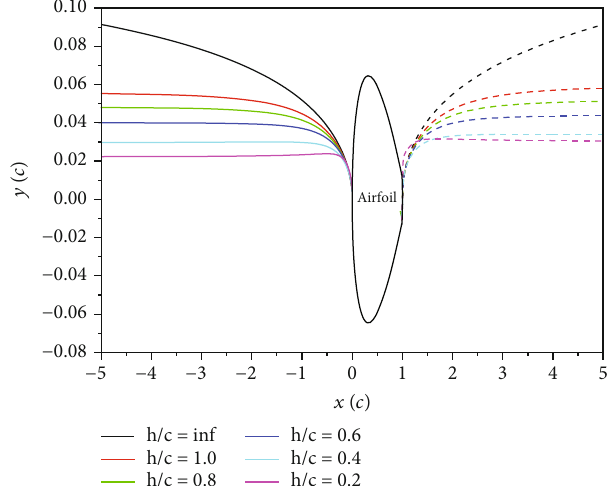
Figure 15: Leading edge stagnation streamlines and the streamlines beginning from the jet separation point on the Coanda surface for C = − 0 : 014 at α = 0 ° μ